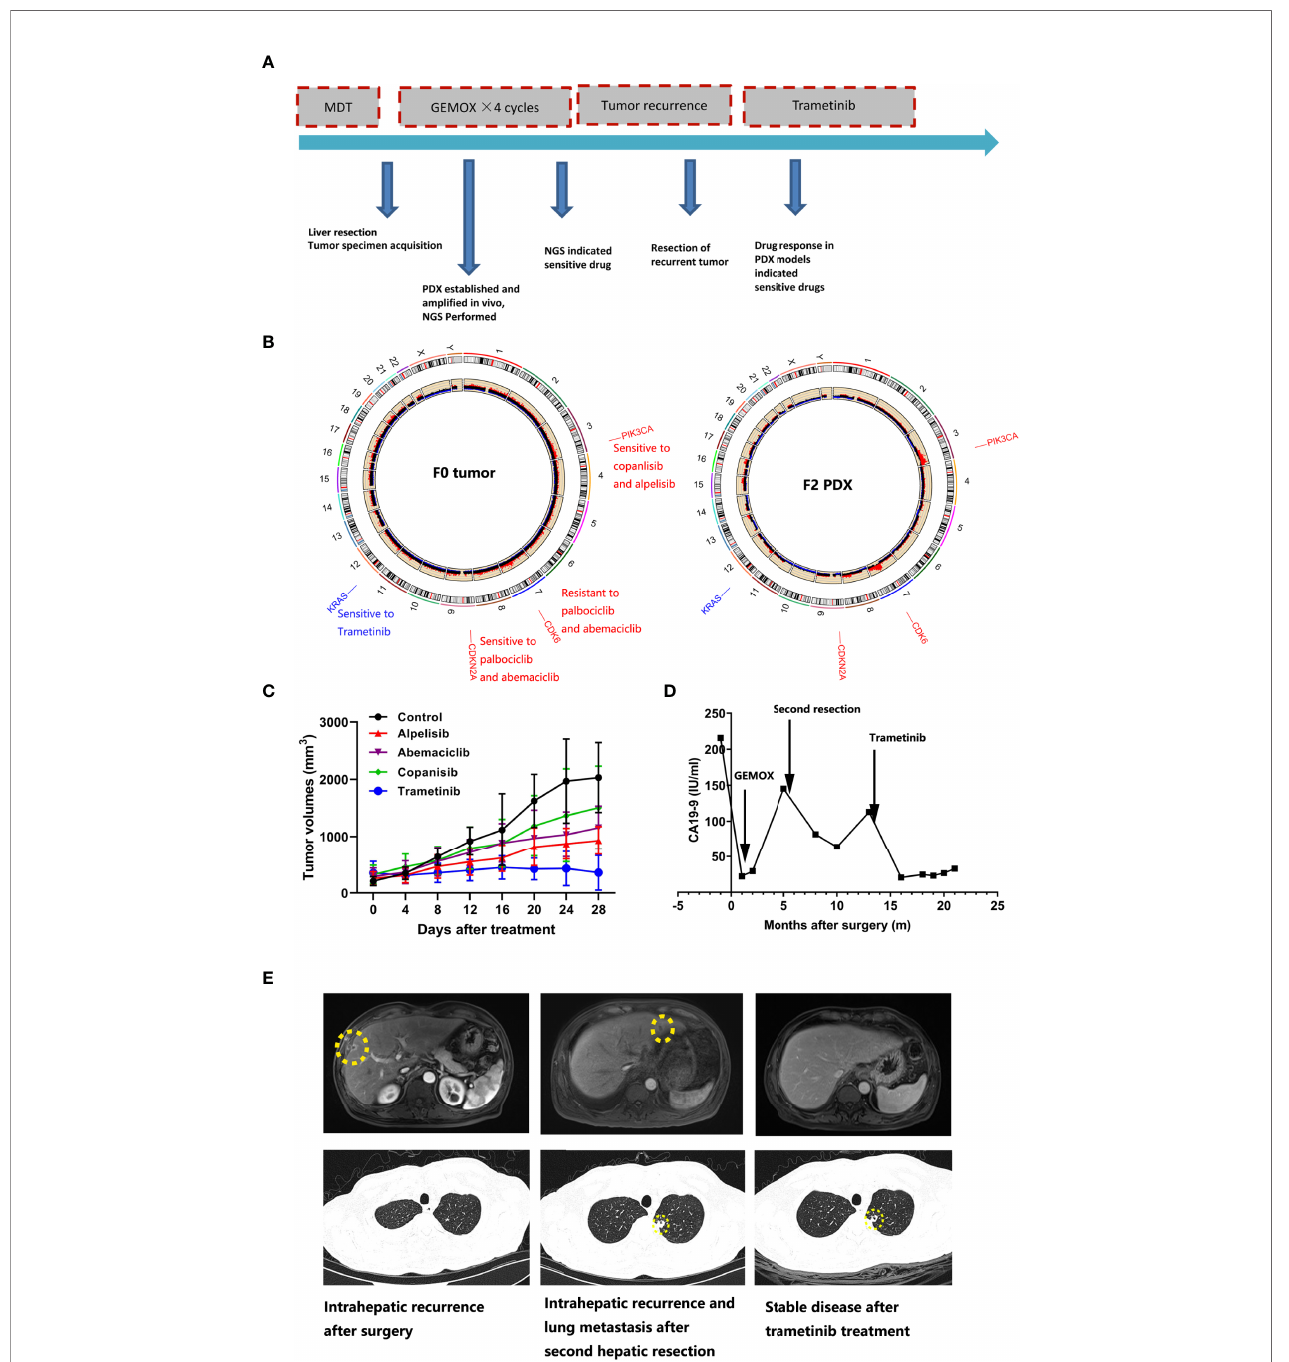
FIGURE 4 | The PDX model combined with the whole exome sequencing data guide drug selection for ICC patients. (A) Summary of clinical history for IMF-11; (B) Whole exome sequencing identi fi ed gene mutations with potential clinical value; right fi gure indicated F0 tumor and left fi gure indicated F2 xenograft tumor; (C) PDX models showed diverse treatment response to various treatment regimens; (D) Human CA19-9 levels were observed during the clinical course; (E) The representative hepatic MRI and lung CT images for patient who received trametinib